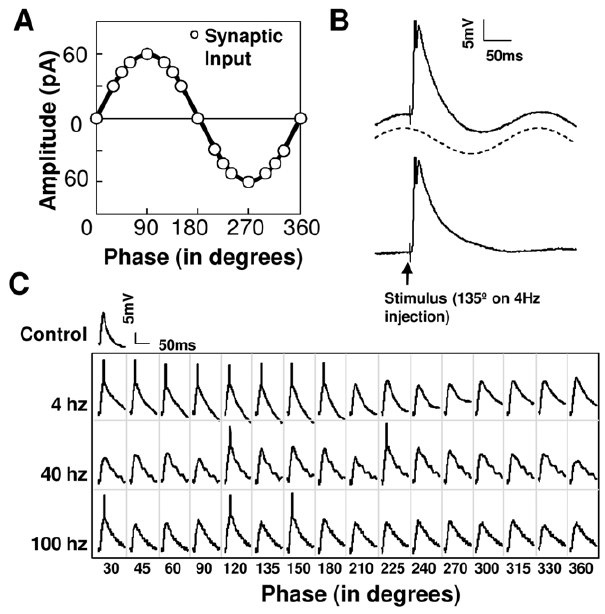
Figure 2. Experimental Design. ( A ) Schematic of stimulus phase relationships. Synaptic inputs were delivered through an electrode to the Schaffer Collaterals at 16 different input phases on the sine-wave background current injection into a CA1 neuron (shown by circles). Thick black line represents the zero mean background input. ( B ) Response readout EPSP area of the non-spiking region gave a measure of the amount of charge injected into in the cell from a single EPSP trace. The APs have been clipped at 20 mV. The latency of the AP was also measured from the stimulus artifact. In the example shown, the afferent input arrives at 135 u to the theta frequency current injection. We calculated the positive area up to 200 ms after the stimulus artifact to get the total EPSP area (top panel). We then obtained a best fit sinusoid to the cell’s response (dashed line). This fitted response was then subtracted from the EPSP trace to get the subtracted EPSP area (bottom panel). ( C ) Raw traces (each of a single trial) shown for a cell’s ( # 210510s1_c1) response to synaptic inputs combined with sine current injection. At certain phases (4 Hz, 0–180 degrees), the synaptic input results in an AP (trimmed). The response of the cell to just synaptic inputs without current injection was used a control. The response of the cell is dependent both on the frequency of sinusoidal current injection and on the phase of synaptic input.